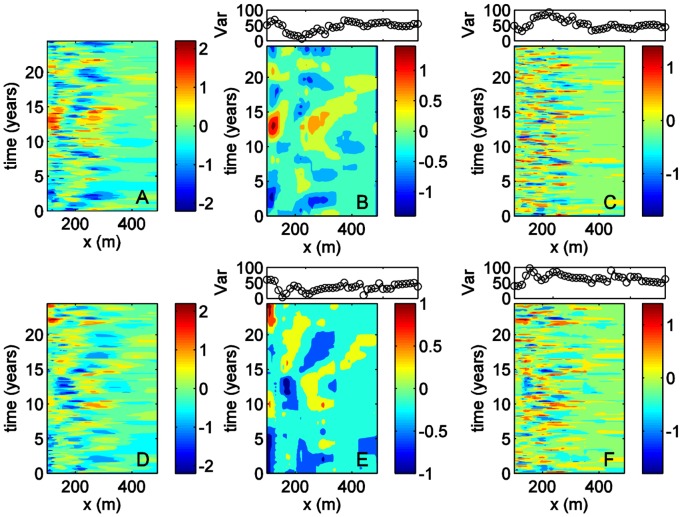
Data, trends and detrended signal contours for transects 58 and 190.The beach elevation (in metres) is displayed in panels A and D, the trend signal elevation (in metres) in panels B and E and the detrended signal elevation (in meters) in panels C and F. The upper sub-panels in panels B, C, E and F show the percentage of variance resolved by the corresponding signal.